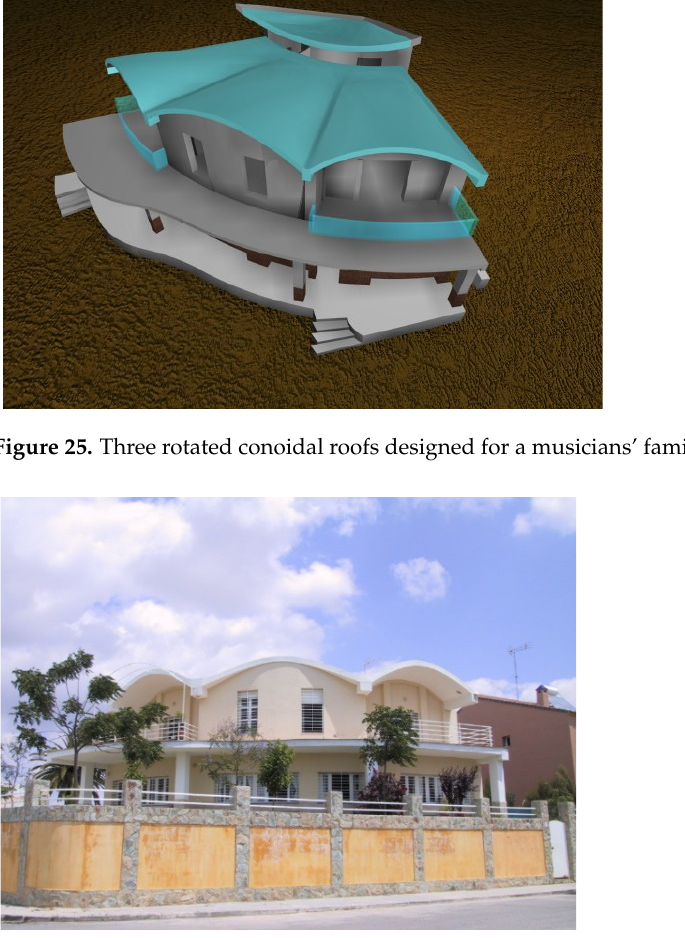
Figure 26. View of the house of the musicians. The vaults are entirely constructed in brick with